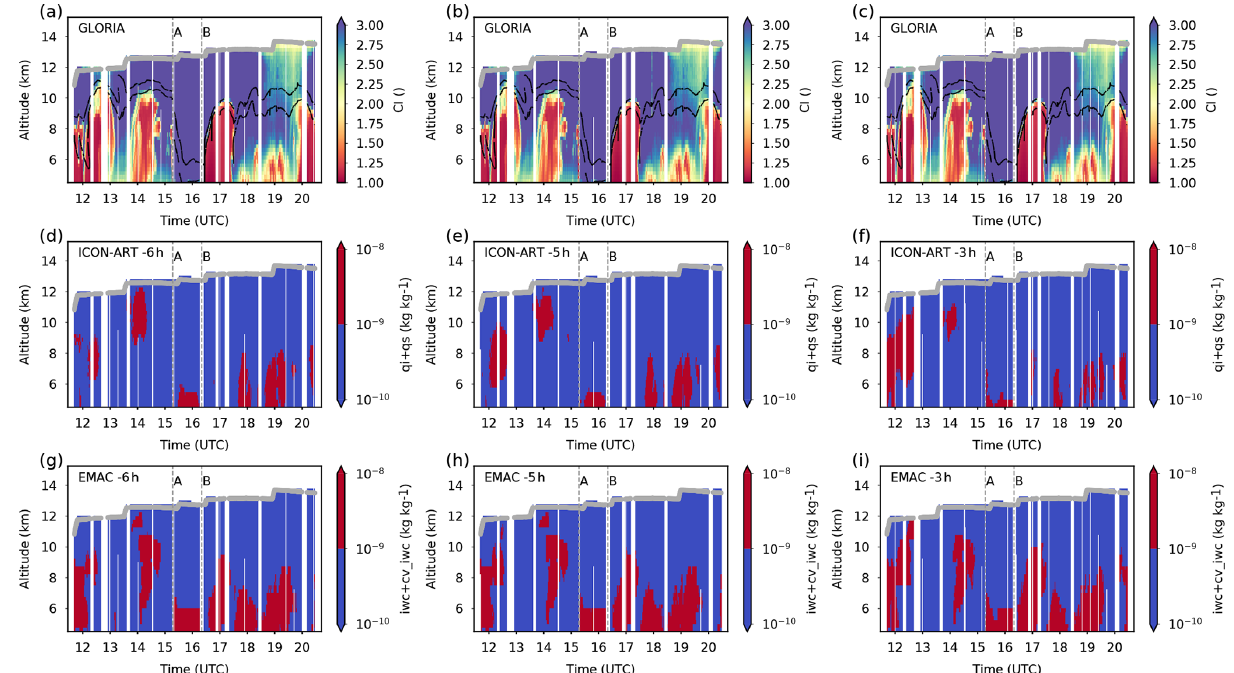
Figure A2. Same as Fig. 5, but model data (ICON-ART and EMAC) have been sampled with a constant time offset of − 6, − 5 and − 3h during the interpolation to the GLORIA geolocations along the flight.